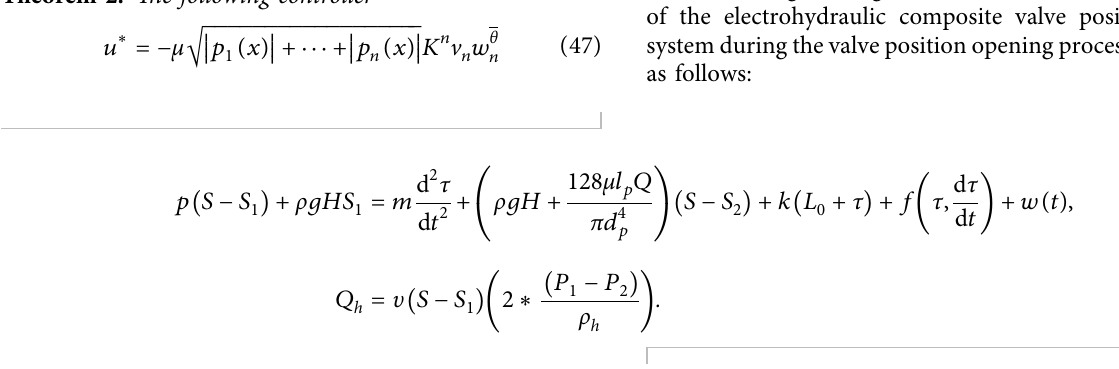
Figure 2. At the same time, due to factors such as